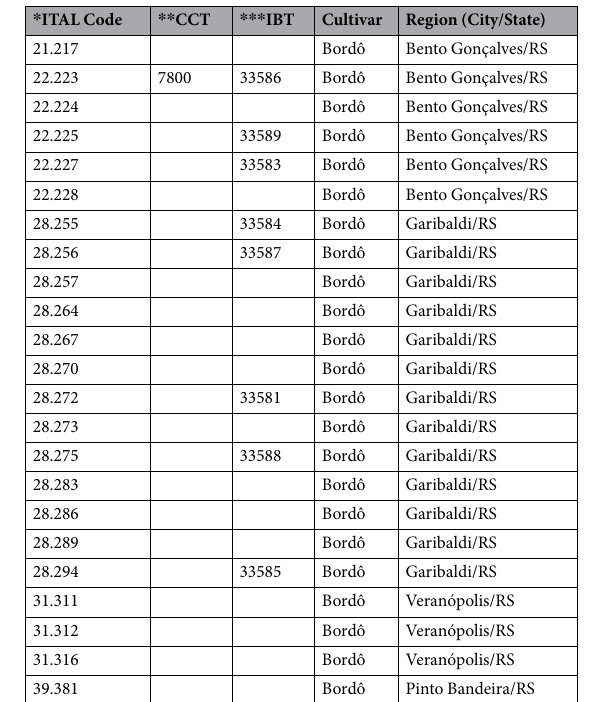
Table 3. Aspergillus labruscus strains from grapes grown in Rio Grande do Sul State. * ITAL = culture collection of the Instituto de Tecnologia de Alimentos, Campinas, Brazil. ** CCT = tropical culture collection of André Tosello Foundation, Campinas, Brazil. *** IBT = culture collection of the Technical University of Denmark, Lyngby, Denmark.